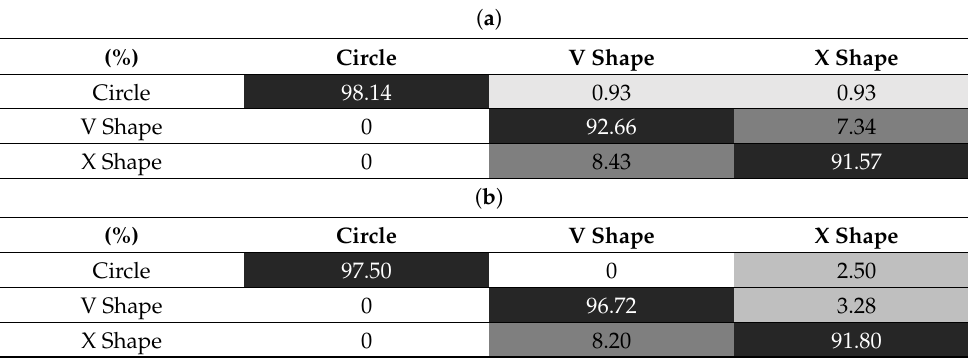
Table 2. Hand gestures classification performance with collected data. ( a ) RNN-BiLSTM; ( b ) RNN- GRU.